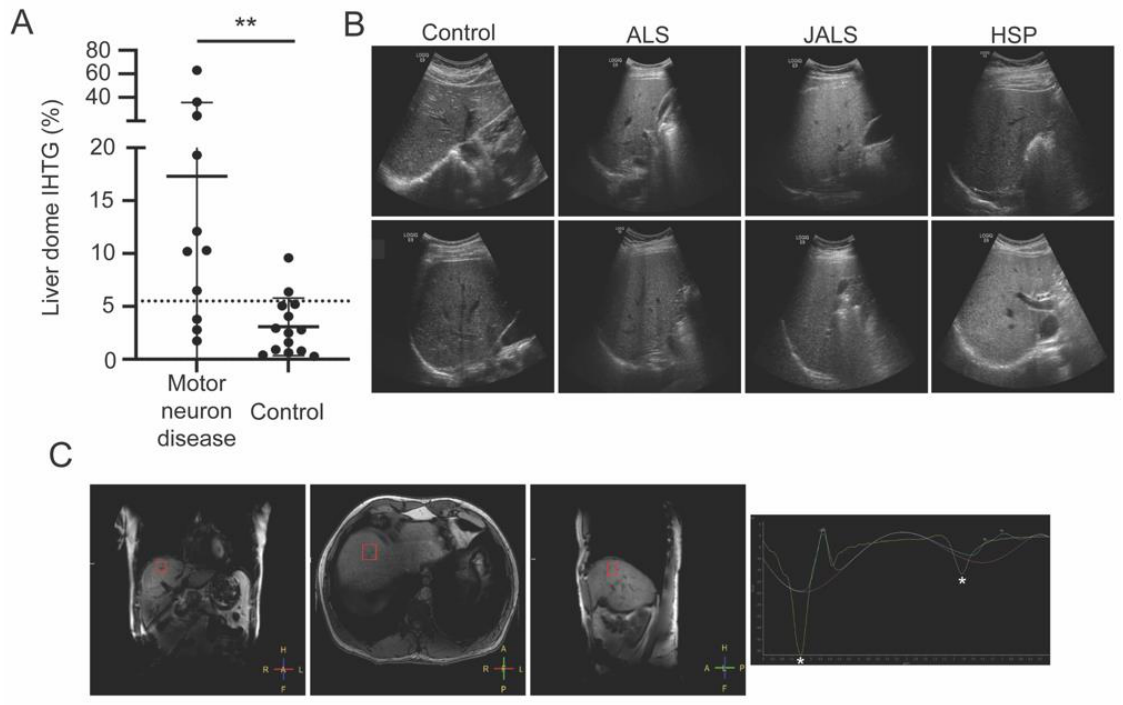
Figure 1. ( A ) 1 H magnetic resonance spectroscopic imaging showed that the motor neuron disease group had a significantly higher intrahepatic triacylglycerol (IHTG) content in the dome of the liver compared to controls (** p = 0.0086); ( B ) increased echogenicity on liver ultrasound showing steatosis in patients with amyotrophic lateral sclerosis (ALS), juvenile ALS (JALS) with mutation in senataxin, and hereditary spastic paraplegia (HSP). Two patients from each category are shown; ( C ) voxel placement (red square) in the liver dome of a patient with HSP and spectroscopy trace showing the peaks for water (left asterisk) and triacylglycerol (right asterisk).